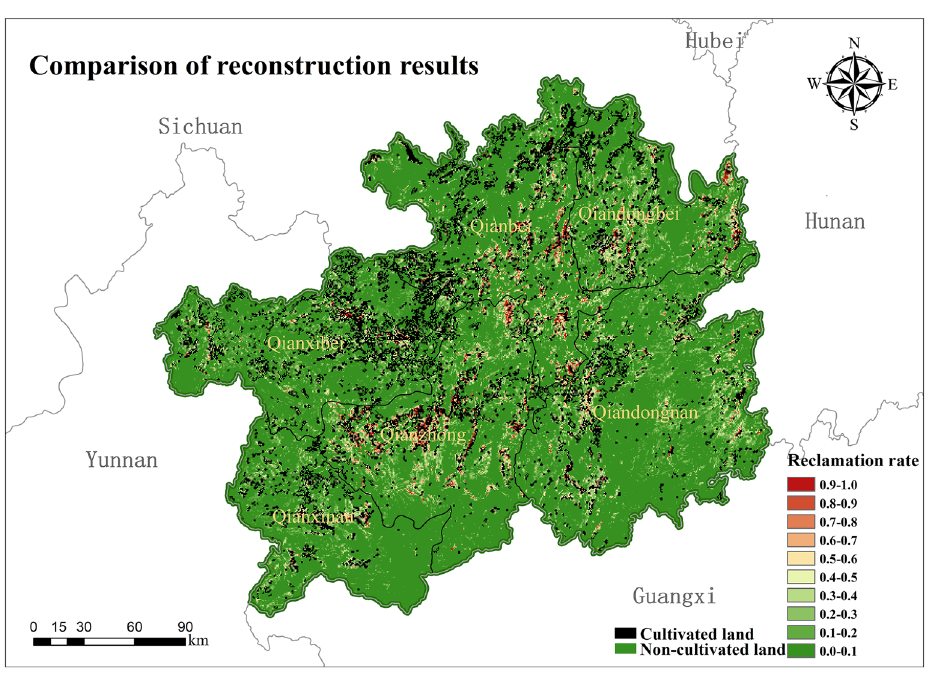
Figure 10. Comparison of cropland reconstruction results (map created using ArcGIS